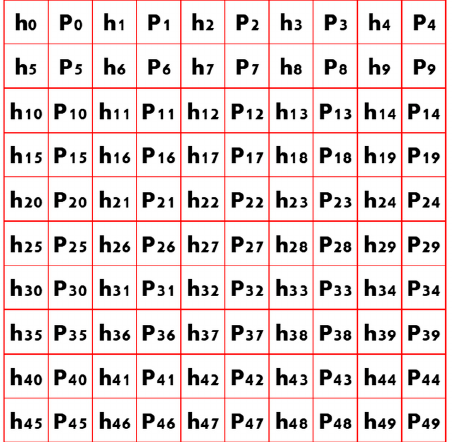
Figure 1. Example of a matrix constructed from the load–displacement curve dataset, here assuming a dataset with 50 rows and 2 columns ( h, P ) arranged in a matrix of float 10 × 10. All the matrices were organized in a dataset X (independent variable). Then, the dataset was scaling, its minimum value was subtracted, and then it was divided by the difference between the maximum and minimum values of dataset X (this operation is known as MinMaxScaler in the scikit-learn library). The objective of scaling the data was to reduce the asymmetry of the multiple dimensions of data ( h , P ), helping with the training process of the CNN model, explained in the next